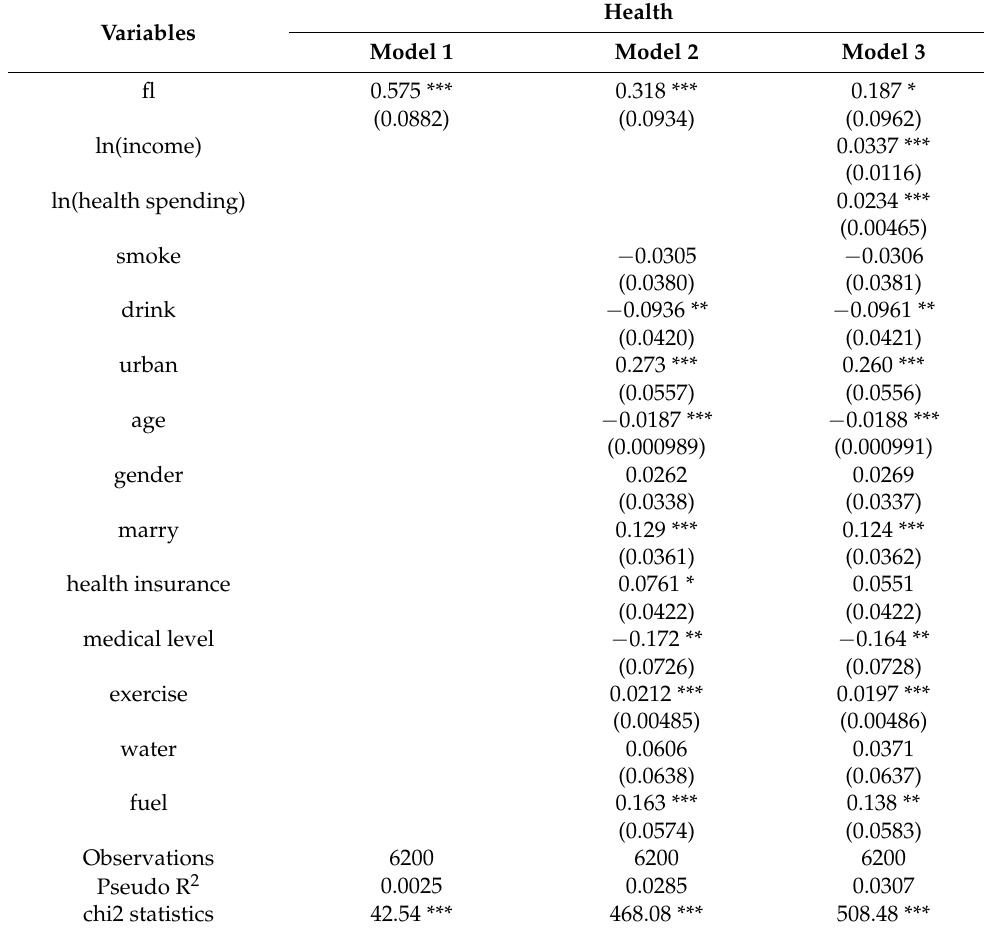
Table 4. Ordered probit regression results of financial literacy and the residents’ health